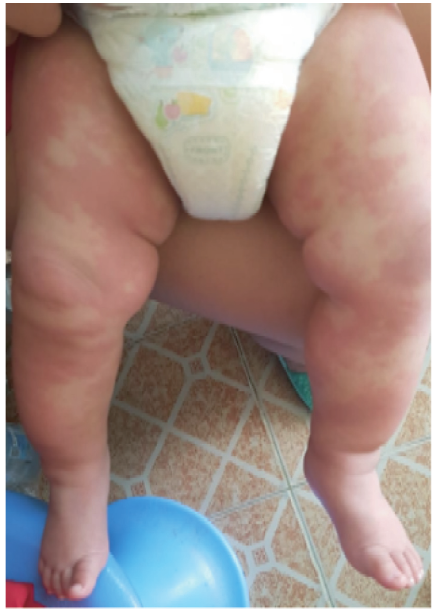
Figure 1: Erythematous rash over the lower limbs.